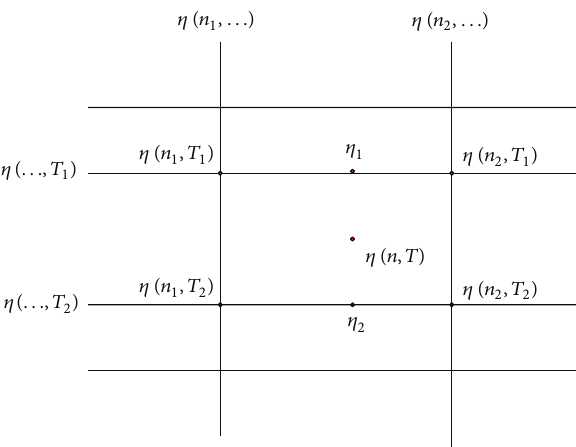
Figure 5: The binary Lagrange interpolation